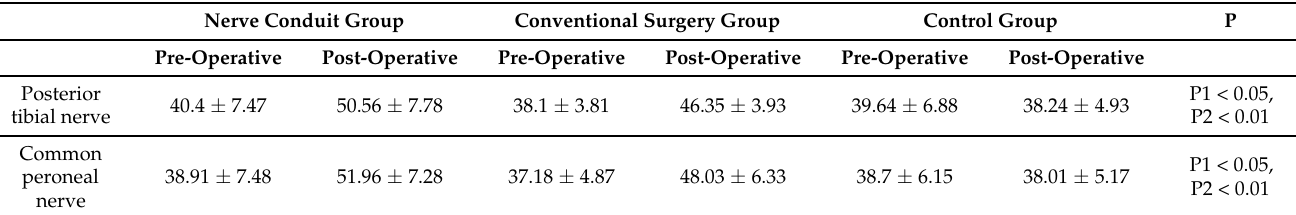
Table 5. Comparison of NCV before and after surgery among the three groups.